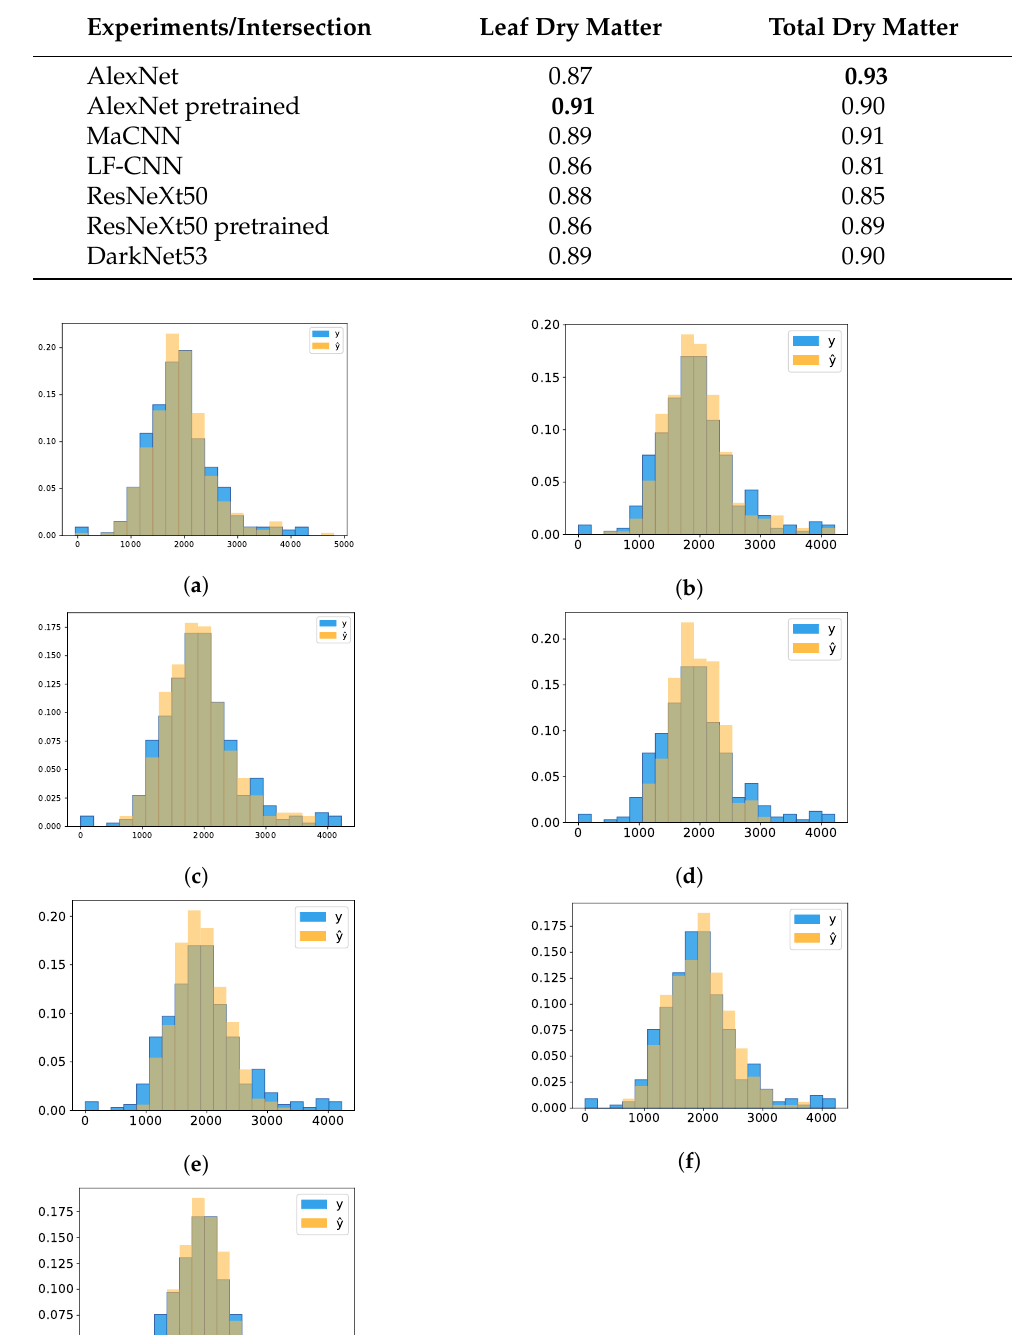
Table 5. Intersection area of histograms.